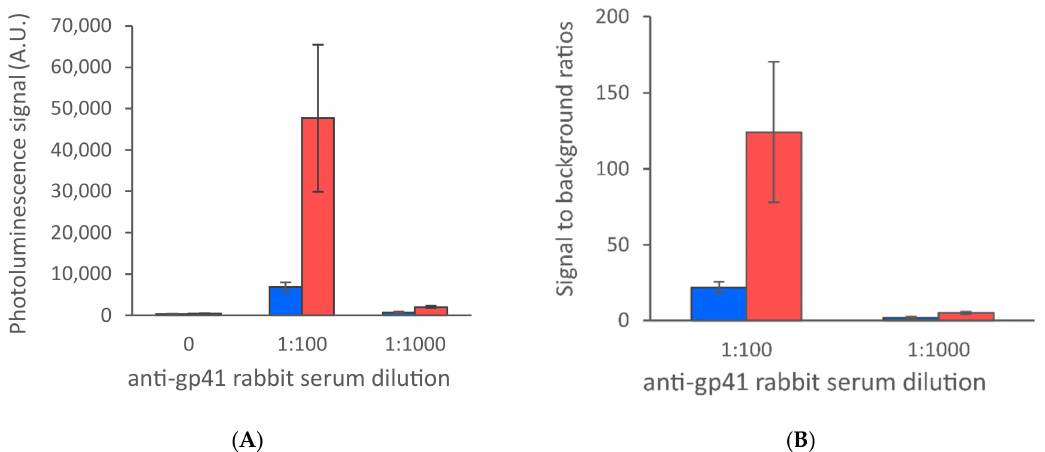
Figure 5. Comparison of liquid-dispensing instruments and line widths. Two different liquid-dispensing instruments (SciSpotter, Scienion AG, and Linomat 5, Camag, Switzerland) were used for line preparation and the test lines dispensed with these instruments were compared in the UCNP-LFA. Thinner lines produced with SciSpotter (red) provided higher signal levels in the presence of anti-HIV antibodies in contrast to the Linomat 5 dispenser (blue). The data are shown as test line maximum photoluminescence signals ( A ) and signal-to-background ratios ( B ). The error bars represent the standard deviation among three replicate strips.